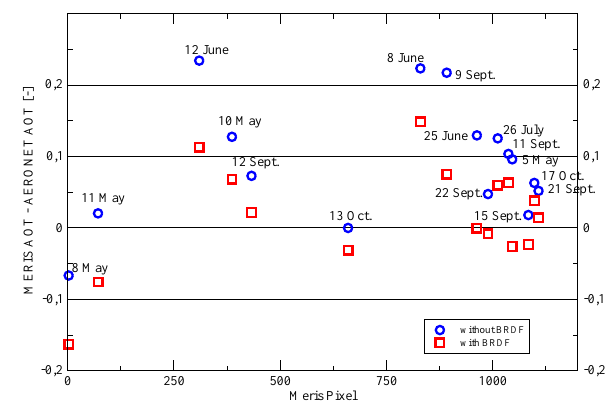
Fig. A1. B RDF as used for the retrieval of aerosol optical depth over Germany for different solar zenith angles (Sinyuk et al., 2006).